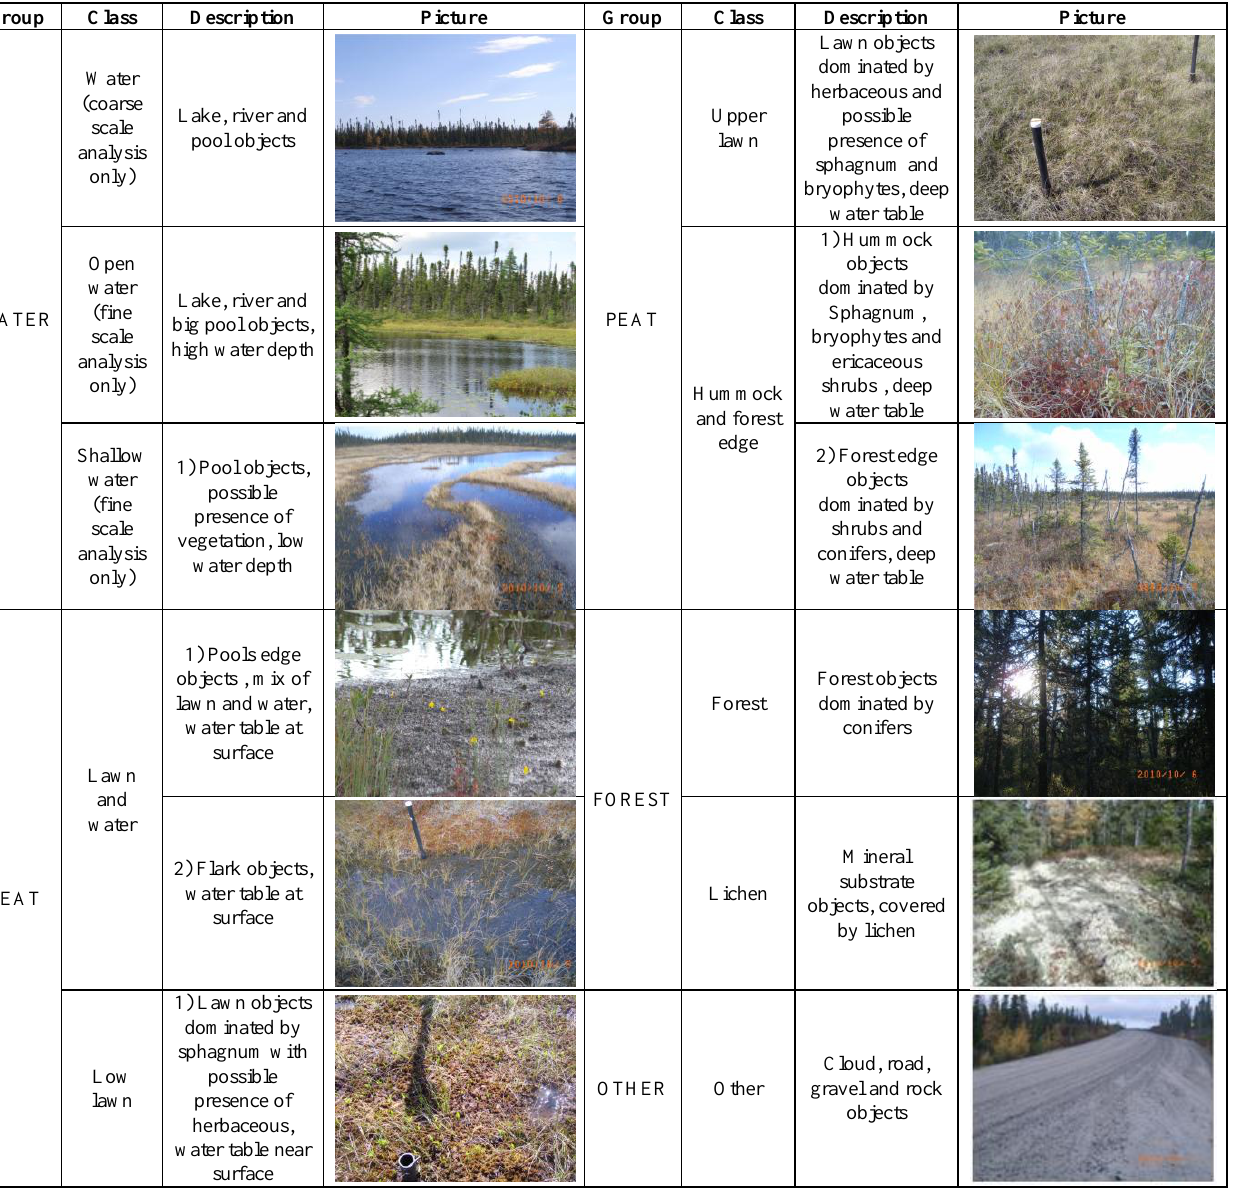
Table 2. Description of the classes used in the object-based